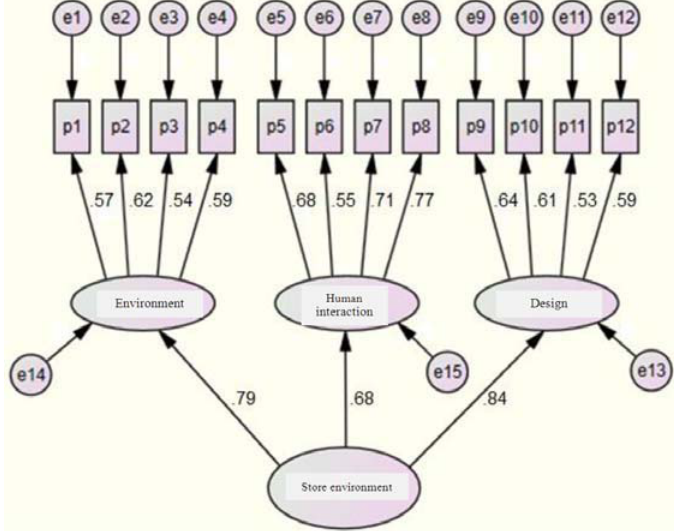
Fig. 2. Second-order confirmatory factor analysis for store environment